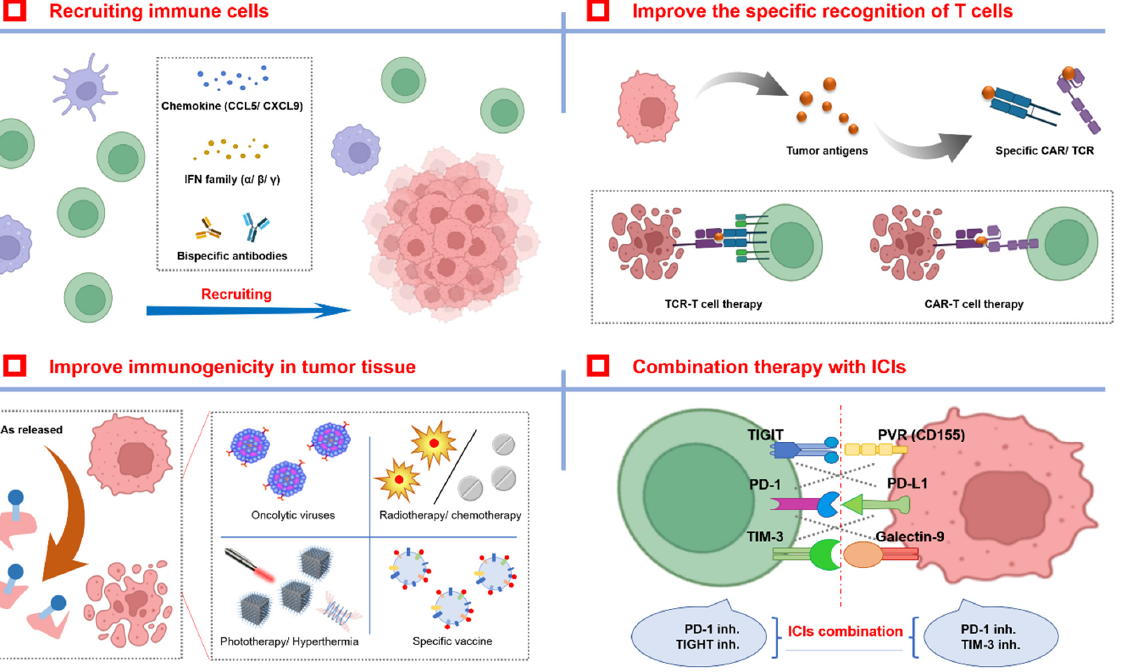
Figure 2. Different therapeutic strategies for overcoming drug resistance with ICIs. There are two main strategies for improving ICI therapy effectiveness and reducing the number of patients with ICI resistance. The first strategy is to improve immune cell infiltration in TME by some cytokines or chemokines, and enhance T cell recognition for tumor cells. The second strategy is to increase the concentration of tumor antigens in THE TME by biological, physical, or chemical methods to facilitate antigen presentation by APC. In addition, the combination of different ICI types may also produce synergistic antitumor effects.